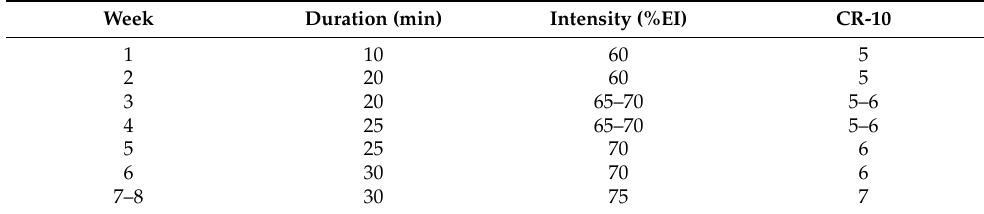
Table 1. Progression of cardiorespiratory workout throughout the 8-week training intervention. Week Duration (min) Intensity (%EI)